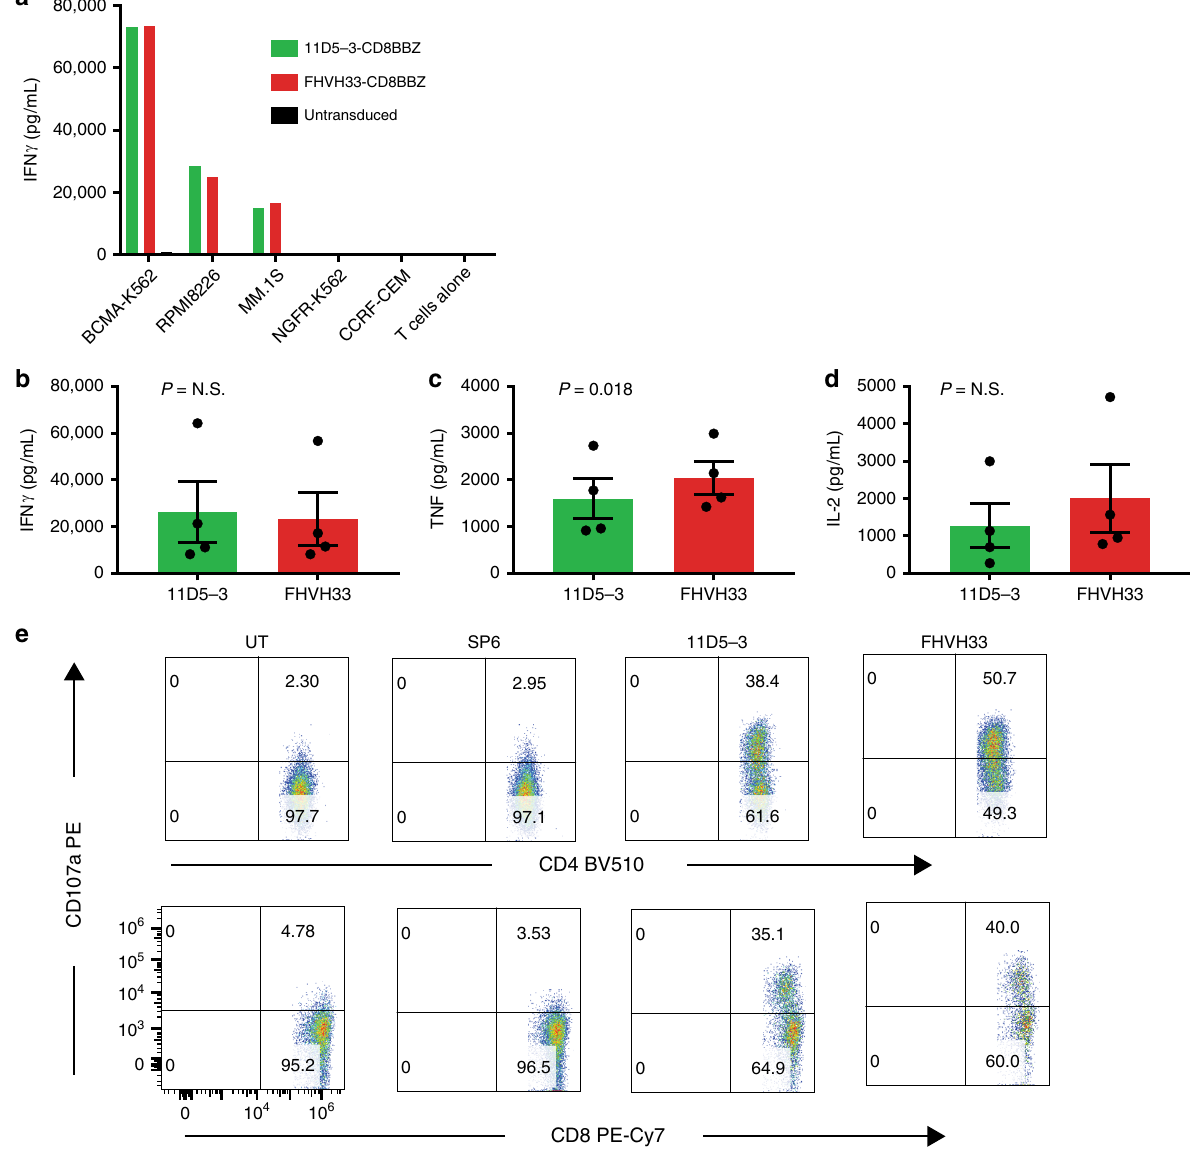
Fig. 3 T cells expressing either 11D5-3-CD8BBZ or FHVH33-CD8BBZ speci fi cally recognized BCMA and primary multiple myeloma cells. a T cells from the same donor were transduced with either 11D5-3-CD8BBZ or FHVH33-CD8BBZ or were left untransduced. T cells were cultured overnight with the indicated target cells, and an IFN γ ELISA was performed on the culture supernatant. Bars represent the means of duplicate wells. Bars representing cultures including untransduced T cells and cultures with BCMA-negative target cells are not visible because the values are too small. Similar results were obtained with cells from four different donors. BCMA-K562, RPMI8226, and MM.1 S are BCMA + ; other target cells are BCMA − ( b – d ) RPMI8226 target cells were cultured overnight with either 11D5-3-CD8BBZ (11D5-3) T cells or FHVH33-CD8BBZ (FHVH33) T cells. Next, an ELISA assay was performed to measure IFN γ , TNF, or IL-2 in the culture supernatant. The amount of nonspeci fi c cytokine release in response to the BCMA-negative cell line NGFR-K562 in parallel cultures was subtracted from the cytokine release in response to RPMI8226 to obtain the RPMI8226-speci fi c IFN γ release. Results are normalized for CAR expression. Mean ± s.e.m. are shown; n = 4. P = N.S. (not statistically signi fi cant) by paired two-tailed t -tests for IFN γ and IL-2; P = 0.018 for TNF. e Patient bone marrow cells that consisted of 56% BCMA + multiple myeloma cells were cultured for 4 h with autologous T cells that were untransduced (UT) or transduced with the SP6-CD828Z negative-control CAR, 11D5-3-CD8BBZ, or FHVH33-CD8BBZ. Cells were stained for CD107a to detect degranulation of CD4 + T cells (top row) or CD8 + T cells (bottom row). Plots are gated on CD3 + live